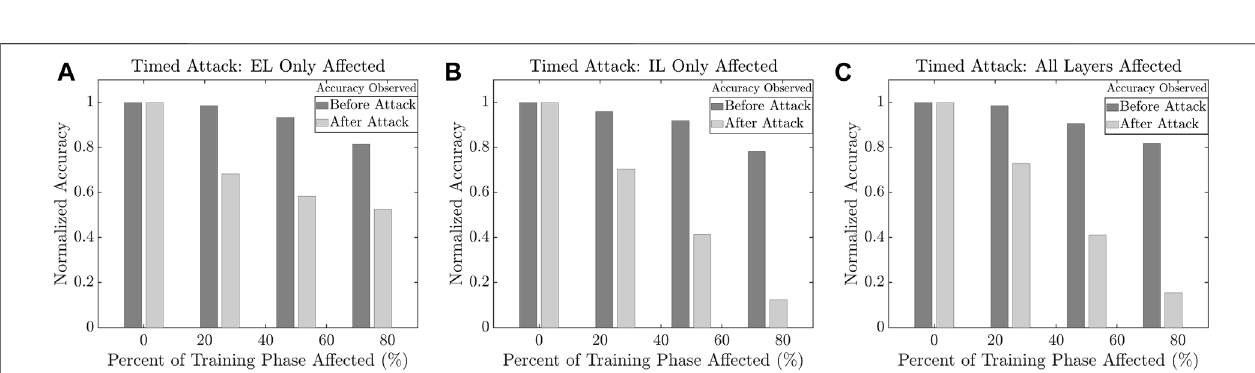
FIGURE10| Classi fi cationaccuracytrendduringtimedthresholdmanipulation(Attack6)of (A) excitatorylayeronly; (B) inhibitorylayeronly;and (C) bothexcitatory layer and inhibitory layer.